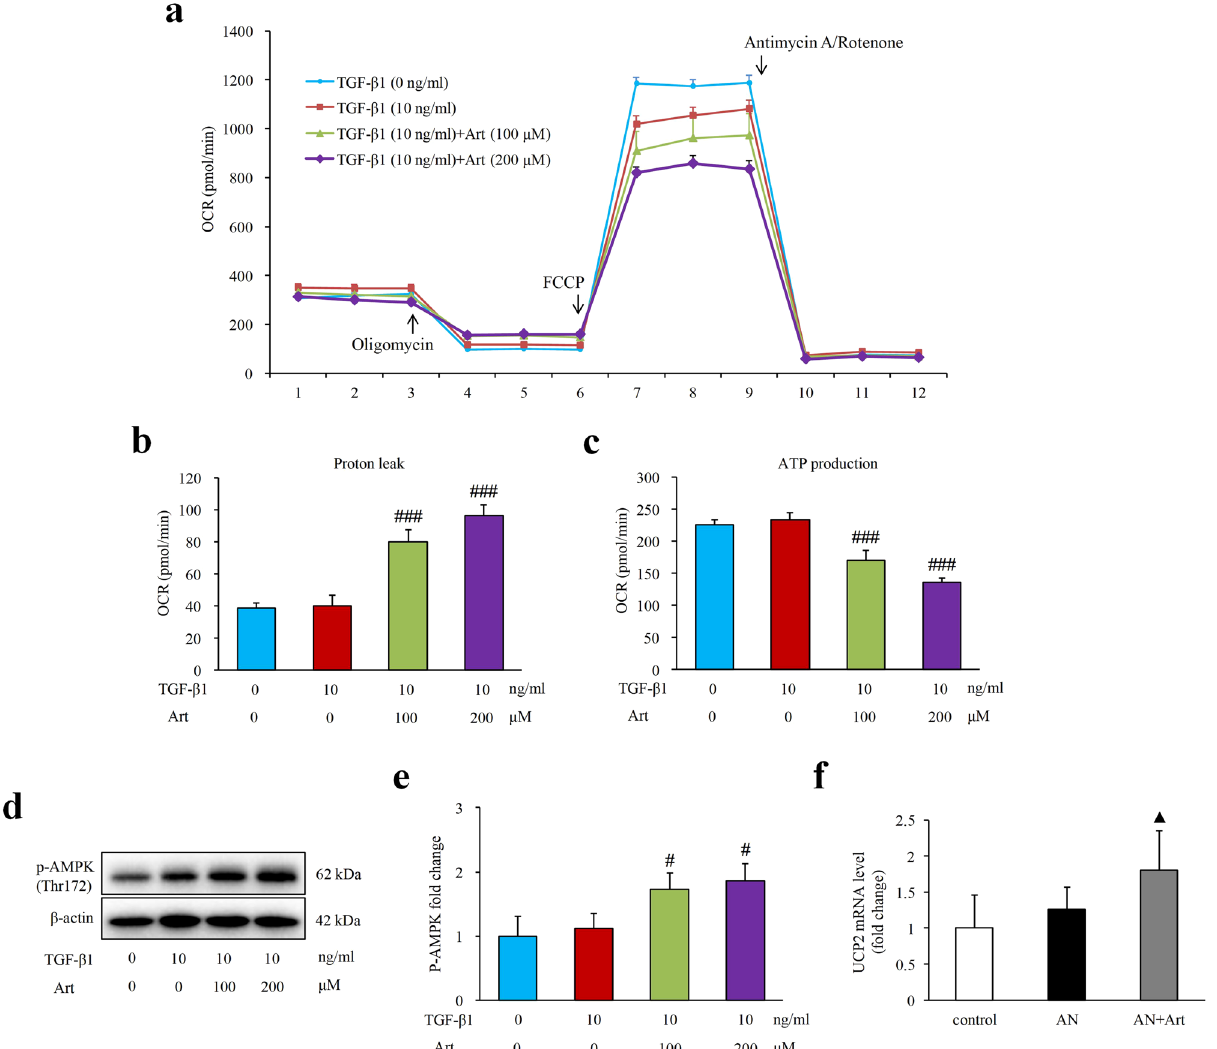
Figure 8. Effects of artemether on proton leak and AMPK signalling. ( a ) Cellular mitochondrial respiration was measured by a Seahorse XF24 extracellular flux analyser after cells were treated with the indicated amount of artemether and TGF-β1 for 24 h. ( b , c ) Bar graphs presenting the calculation of proton leak and ATP production in various groups according the manufacturer’s protocol. n = 5 per group. ( d , e ) Representative western blot images and quantitative analysis of p-AMPK (Thr172) fold change after TGF-β1 and artemether treatment for 24 h. n = 3 per group. ( f ) Renal mRNA expression level of UCP2 in each group mice normalized against the housekeeping gene β-actin. n = 6 per group. # P < 0.05 and ### P < 0.001 versus TGF-β1:10 + Art: 0 group; ▲ P < 0.05 versus